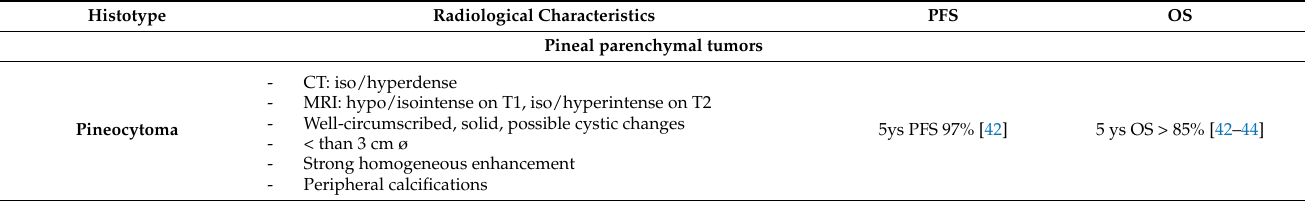
Table 2. Summary of radiologic characteristics and survival outcomes in most frequent pineal parechymal tumors and germ cell